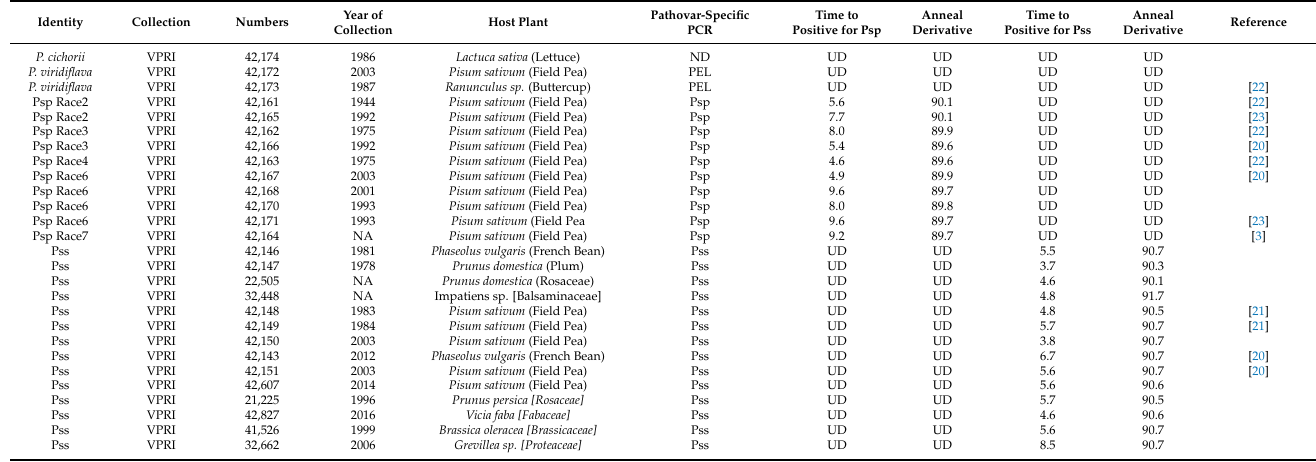
Table 1. Description of isolates used for designing and validation of the loop-mediated isothermal amplification (LAMP) assays for the detection of Pseudomonas syringae pathovars pisi (Psp) and Pseudomonas syringae pathovars syringae (Pss).